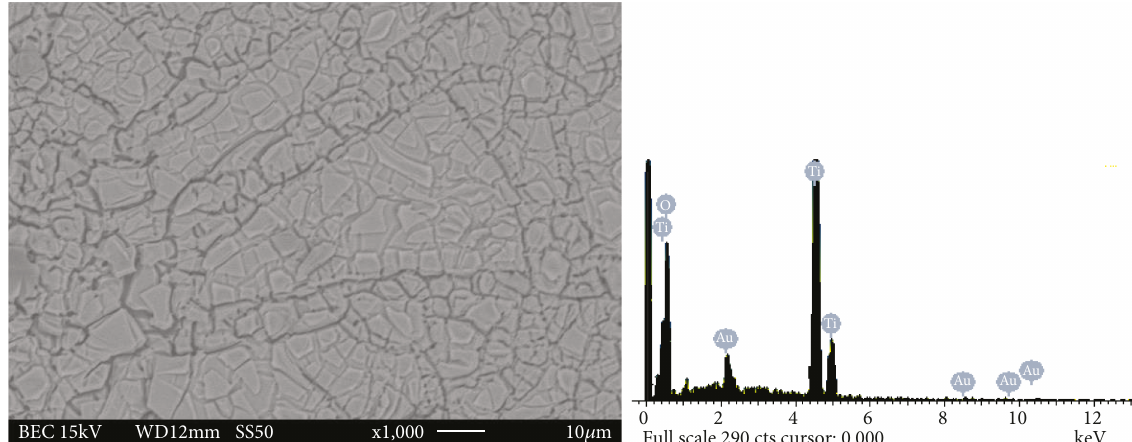
Figure 6: SEM image after 3 treatment cycles using stirring plate and 1 hour of immersion.